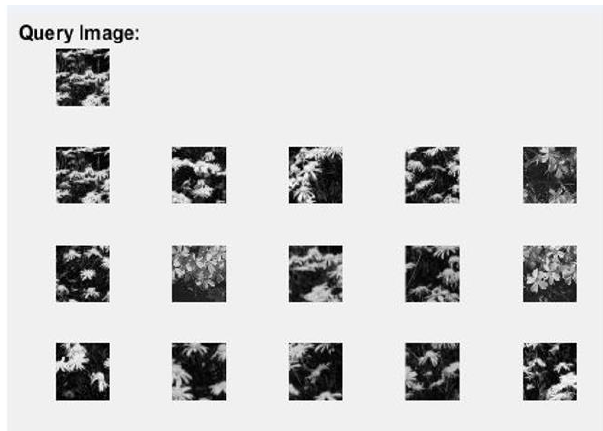
Figure 9. Retrieval result of a query image from Vistex dataset